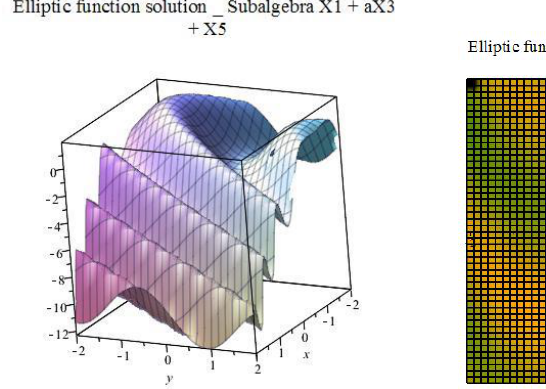
Figure 14. Solitary wave profile depiction of elliptic solution (84) at t =